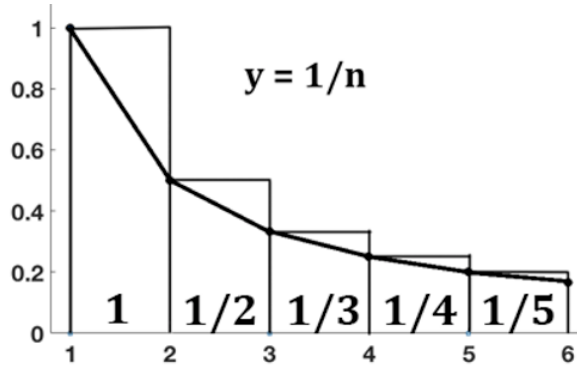
Fig. 3. An approximation of the area under the hyperbola y = 1/x by the sum of areas 1, 1/2, 1/3, 1/4, … , 1/n of the shown rectangles, whose areas form the series of harmonic numbers Hn